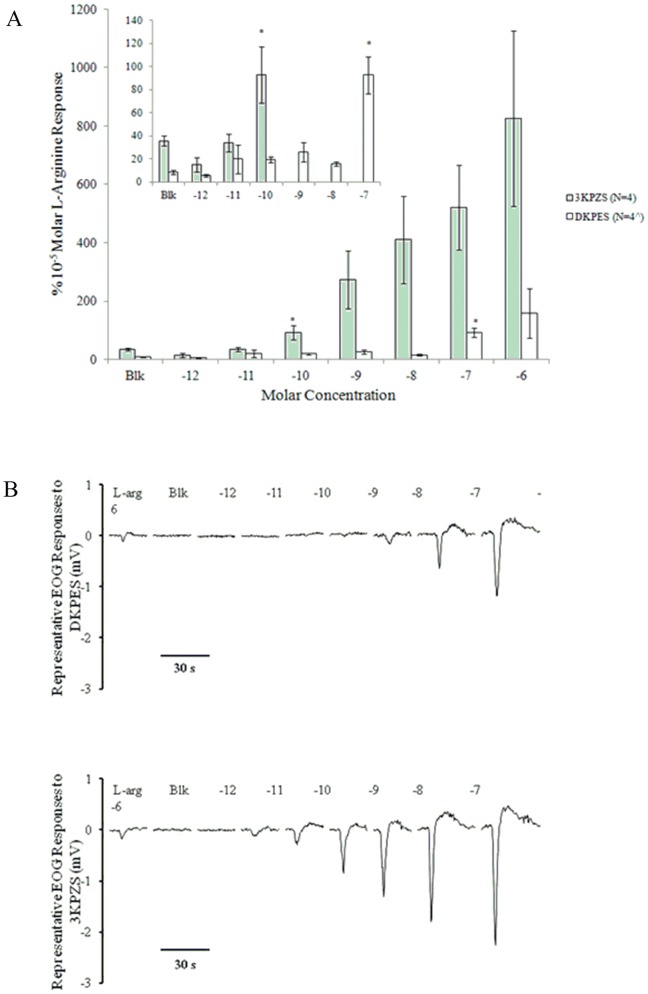
Electro-olfactogram (EOG) responses to lamprey bile salts.A. Semi-logarithmic plots of EOG responses. Semi-logarithmic plots of EOG response in millivolts (mV) to a 10−5 Molar L-arginine standard (L-arg), blank water control (Blk), and increasing concentrations of DKPES and 3 KPZS are presented in the top graph. Semi-logarithmic plots of EOG concentration-responses to DKPES and 3 KPZS as a percentage of the L-arg standard are presented in the bottom graph. The response thresholds for DKPES and 3 KPZS are the lowest concentrations that elicit a response significantly greater than the blank water controls (Blk) and are depicted by asterisks (Student’s t-test, P<0.05). The inset shows a detailed view of the response thresholds. Numbers by the abbreviation indicate sample sizes. The carat indicates that the sample size was not achieved for all odor concentrations (see Table 2). Vertical bars represent one standard error. B. Representative EOG responses of an adult sea lamprey to 3 kPZS and DKPES in concentrations between 10−12 and 10−8 molar. The olfactory epithelium was exposed to each odorant for 5 sec. L-arg: L-arginine at 10−5 molar. Blk: blank water. The number above each EOG trace is the logarithmic value of the molar concentration of bile salts applied to the sensory epithelium.